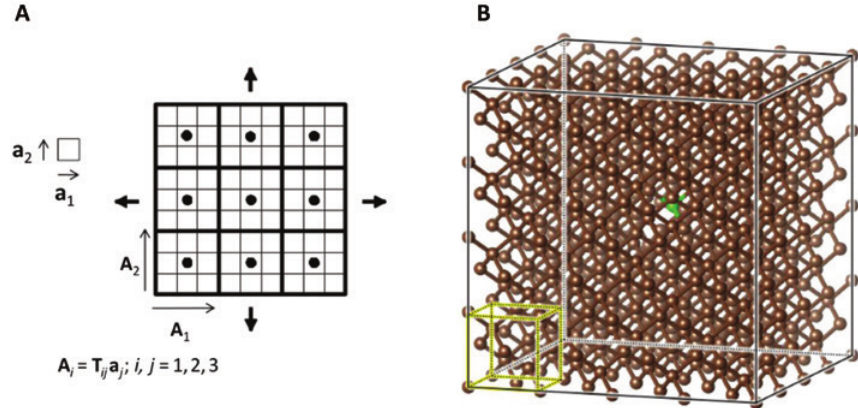
Figure 2: (A) Schematic diagram of the supercell method for the modeling of point defects in a solid. The small square is the unit cell. The point defect is represented by a dot that is embedded in a 3 × 3 supercell in this particular example. Generally, the nonsingular transformation matrix T contains only integers, which transforms the lattice vectors of the unit cell ( a ) to those of the supercell ( A ). The periodic images of the defect may represent a problem, in particular, for charged defects. (B) 512-atom simple cubic supercell of diamond hosting the NV center (carbon and nitrogen atoms are brown and green balls, respectively). The Bravais unit cell is also shown as a small